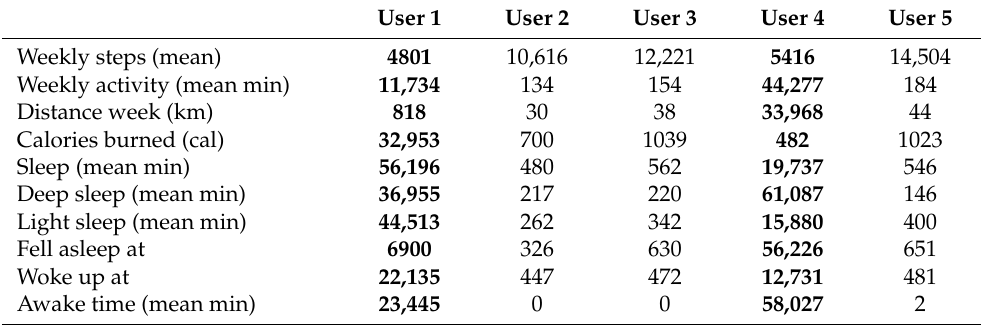
Table 5. Recovered plain text of five users, where bold numbers denote incorrect